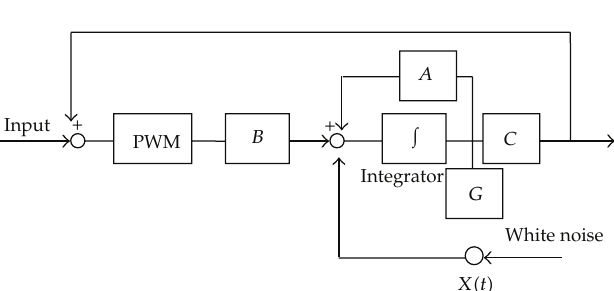
Figure 1: Block diagram of PWM feedback systems subjected to multiplicative disturbances (cid:5) 20 (cid:6)